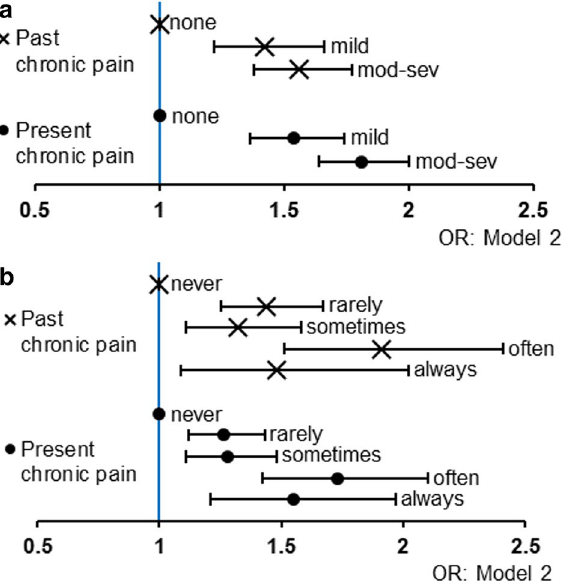
Figure 6. Loneliness/social isolation and history of past/present chronic pain. ( a ) Odds ratios of the prevalence of past and present chronic pain in model 2 by the degree of loneliness; ( b ) Odds ratios of the prevalence of past and present chronic pain in model 2 according to the frequency of feelings of social isolation. X-axis indicated odds ratio. Bars indicated 95% confidence intervals. Abbreviations: mod‑sev moderate-to-severe; OR odds